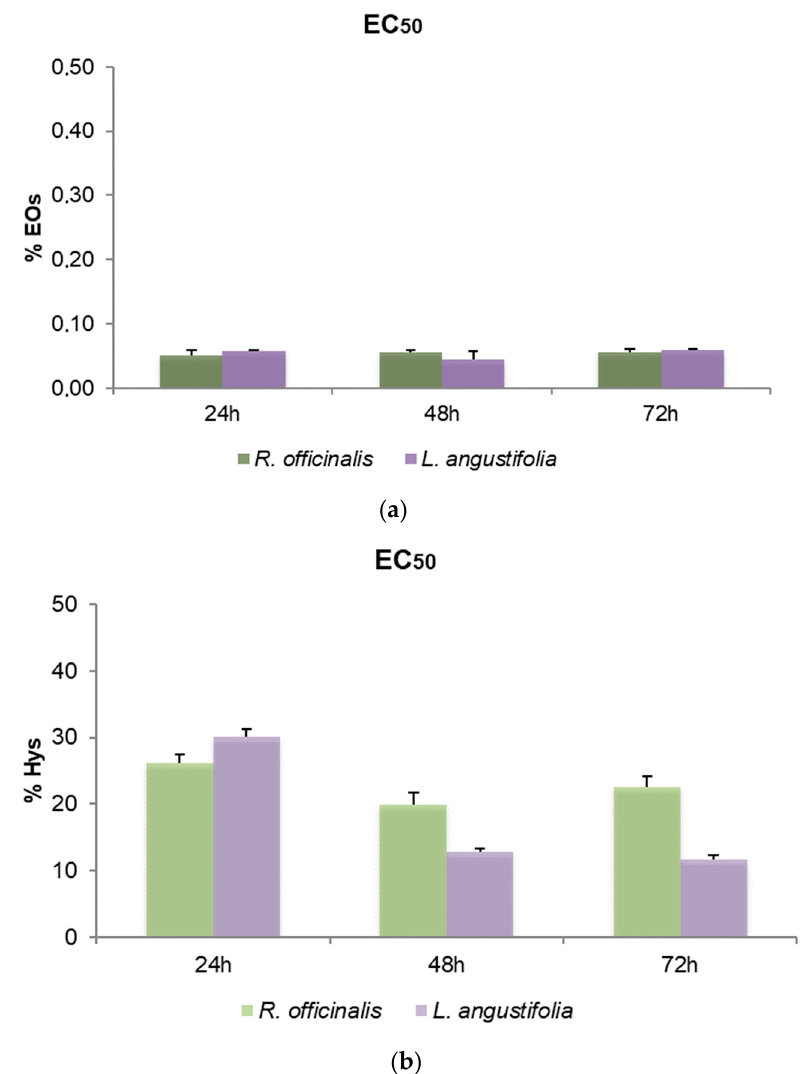
Figure 3. Bar graphs of EC 50 values obtained by thiazolyl blue tetrazolium bromide assay (MTT) after 24, 48 and 72 h of SHSY5Y cell treatments, ( a ) with R. officinalis and L. angustifolia EOs and ( b ) with the corresponding Hys. Error bars: standard deviation.